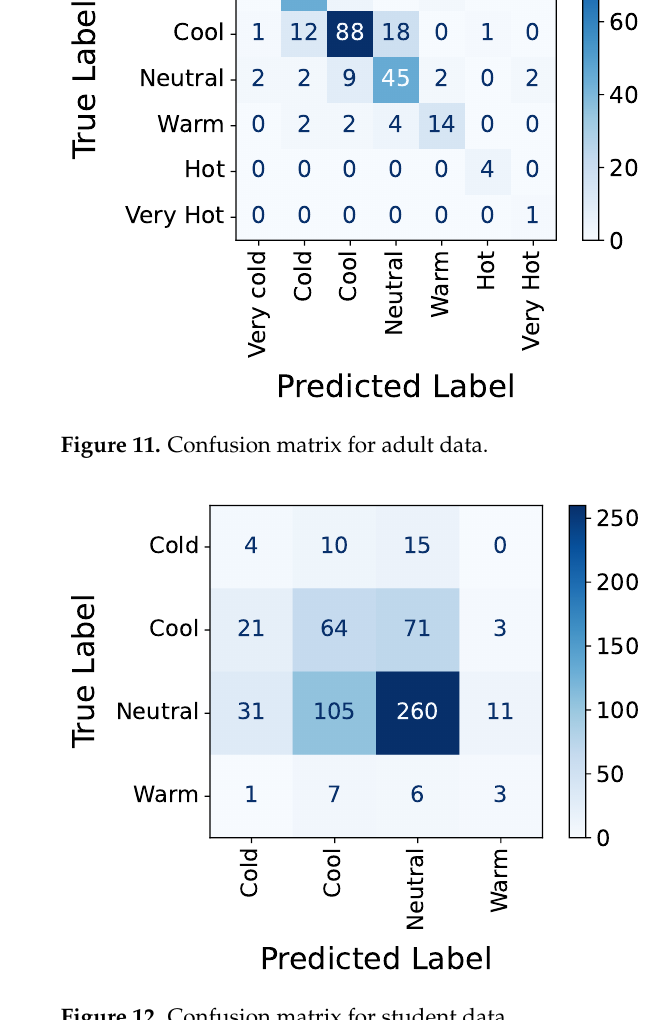
Figure 12. Confusion matrix for student